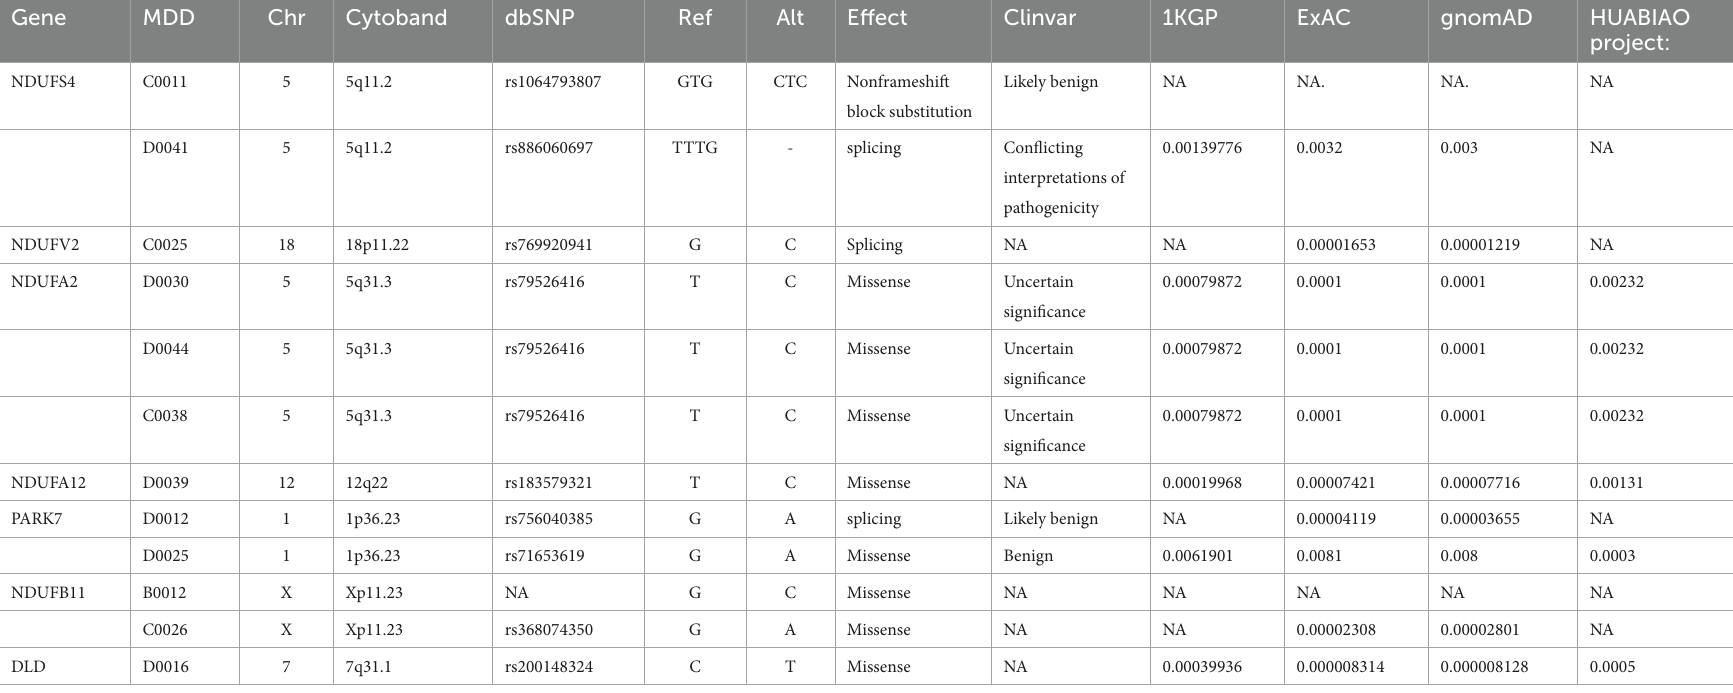
TABLE 2 The seven hub genes mutated in eCB pathway in patients with MDD.